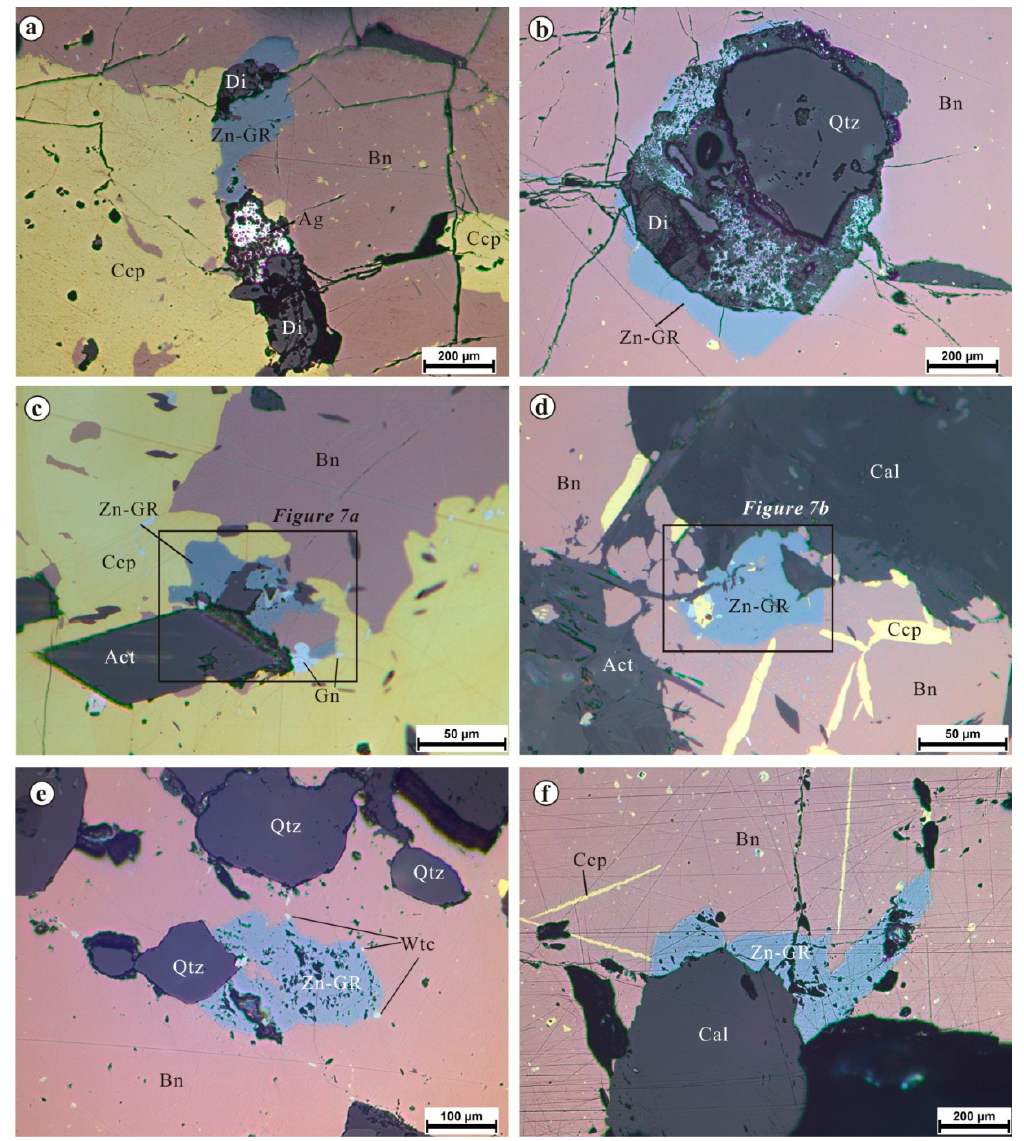
Figure 6. Reflected light photomicrographs of zincian greenockite. ( a ) zincian greenockite (Zn-GR), native silver (Ag), and diopside (Di) between chalcopyrite (Ccp) and bornite (Bn) grains; ( b ) zincian greenockite occurs in the contacts between bornite and diopside (Di) and quartz (Qtz); ( c ) zincian greenockite as a subrounded grain at the margin of the chalcopyrite associated with actinolite (Act) and galena (Gn) (the detailed back-scattered electron (BSE) images can be observed in Figure 7a); ( d ) zincian greenockite at the contact between bornite and actinolite (the detailed BSE image can be observed in Figure 7b); ( e ) zincian greenockite with wittichenite (Wtc) filling and replacing the bornite; ( f ) zincian greenockite filling in the fractures of bornite, and its association with calcite (Cal).